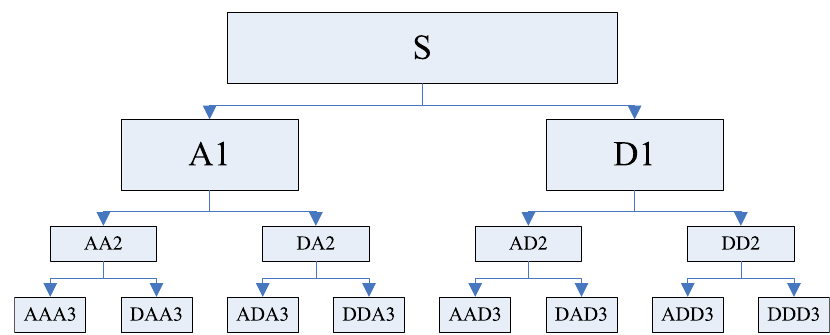
Fig. 1. Diagram of wavelet